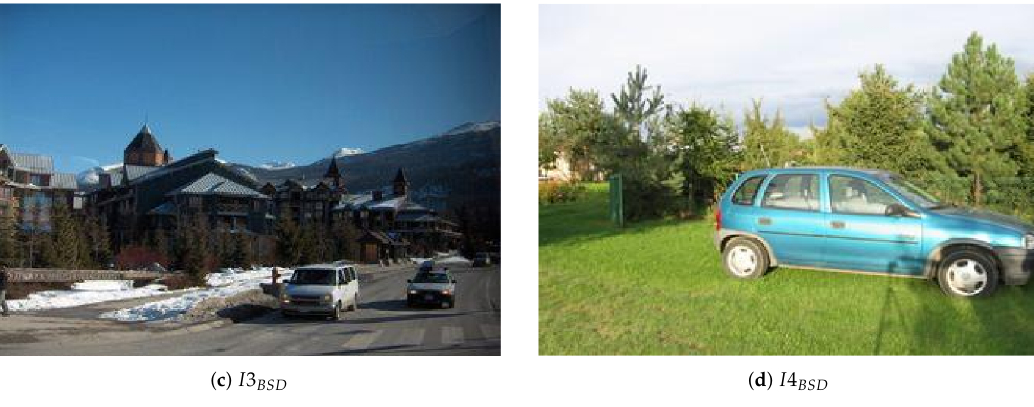
Figure 3. Examples of SBD